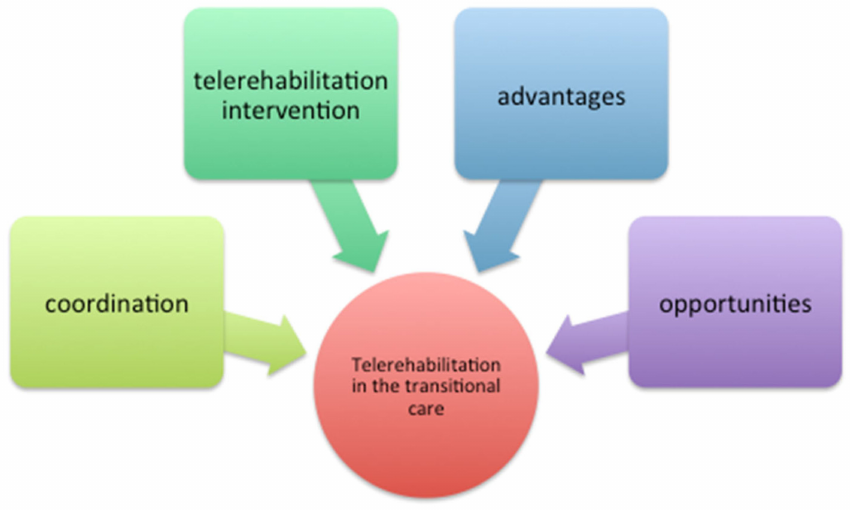
Figure 1. Relation between categories. Lisbon,